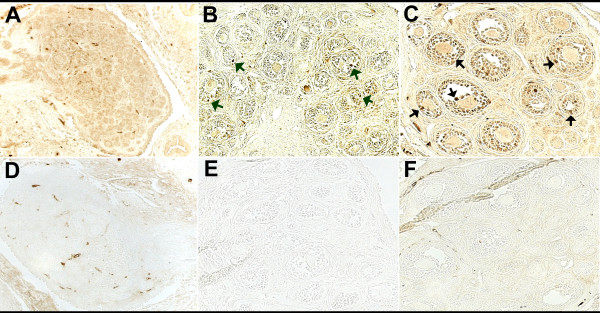
Immunolocalization of PPARγ in ovarian tissue sections collected from neonatal rats day 5 (A, D), 7 (B, E), and 11 (C, F) pp (n = 3-4 animals/time point). Tissues were collected and processed as described in the Methods. PPARγ is identified by the brown reaction product. Tissues in D, E, and F were processed with normal goat serum in place of the anti-PPARγ antibody. Arrows in B and C indicate granulosa cells expressing high levels of PPARγ. Original magnification = 200×.